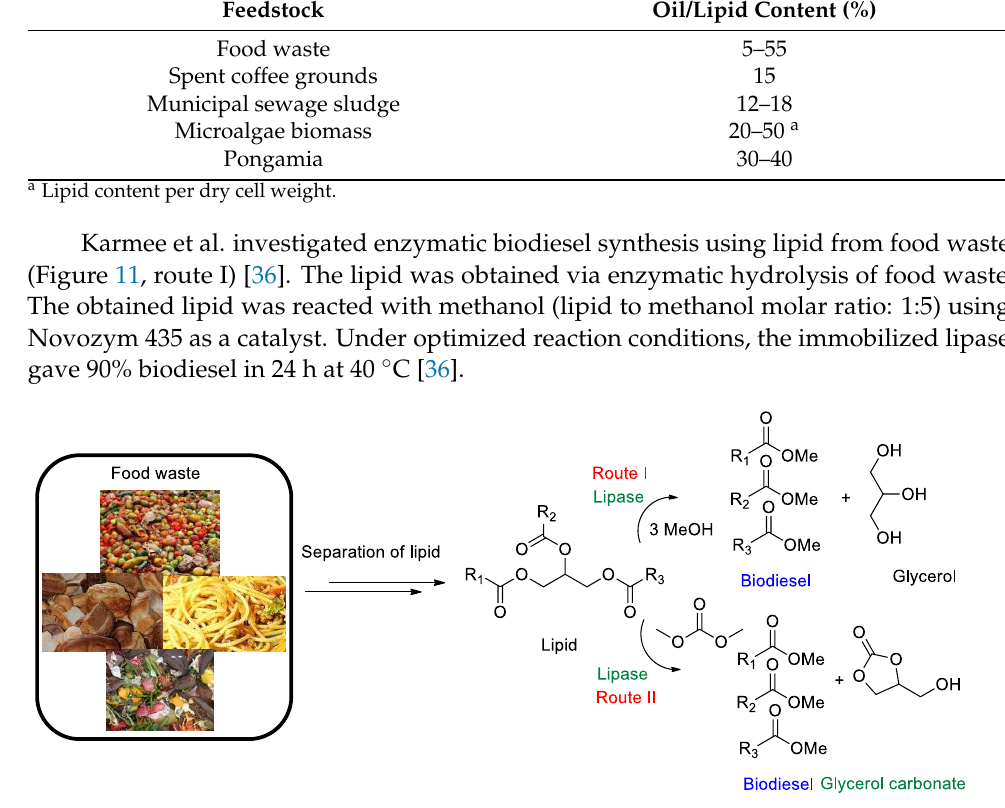
Figure 11. Lipase-catalyzed production of biodiesel from food waste. Noodles are available in packets in markets and they are a common staple food in many countries. In general, oil is used to fry noodles to preserve them and to increase the shelf life. The oil from noodle waste has been investigated for biodiesel synthesis [37–39]. Yang et al. reported Novozym 435-catalyzed biodiesel preparation using oil isolated from noodle waste [37]. The authors observed a 95.4% biodiesel conversion in 36 h [37]. The optimum reaction parameters were an oil to methanol molar ratio of 1:9, enzyme amount of 15% ( w / v ), water amount of 2% ( w / v ) and temperature of 40 °C. Methanol was added in three potions to avoid deactivation of the lipases and loading times were at 0, 4 and 16 h [37]. To circumvent the deactivation of lipases during biodiesel preparation, dimethyl carbonate can be used. For example, food waste lipids can potentially be used for the co-production of biodiesel and glycerol carbonate using lipase and dialkyl carbonates (e.g., dimethyl carbonate) (Figure 11, route II). Such a method is attractive since it is glycerol-free and the resulting product (glycerol carbonate) has a wide range of applica- tions as a solvent and starting material in polymer industries. Food waste hydrolysate is used as a nutrient for the culture of lipid-producing mi- cro-organisms. It is reported by Zeng et al. that when mixed cultures of Rhodosporidium toruloides and Chlorella vulgaris (yeast and microalgae) are used for food waste treatment, the experiments gave a higher amount of lipids in a short cultivation time as compared to a pure culture of Rhodosporidium toruloides [40]. The results indicate that yeast and mi- croalgae mixed cultures can be used strategically for biofuel production from food waste. Along the line, Zhang et al. reported the use of anaerobic-digested effluent from kitchen waste for microalgae cultivation [41].The lipid content in Chlorella sorokiniana SDEC-18 was 30.27 – 41.69%, whereas Scenedesmus SDEC-8 gave 35.97 – 47.39% lipid con- tent under optimum experimental conditions [41]. The resulting biomass was harvested and the cell was disrupted to yield the oil, which was subsequently used for biodiesel production. To overcome the cost related to microalgae biomass drying and oil extrac- tion, direct use of the harvested, lipid-enriched microalgae biomass via insitu transester- ification is being investigated [35]. During the insitu transesterification, oil extraction and conversion of lipids to biodiesel takes place simultaneously in one pot (Figure 12) [35]. Many researchers are also investigating single-step techniques for simultaneous celllysis and the extraction of lipid from microalgae using ultrasound-, microwave-, bead-beating-, surfactant- and pulsed electric field-assisted methods [42].